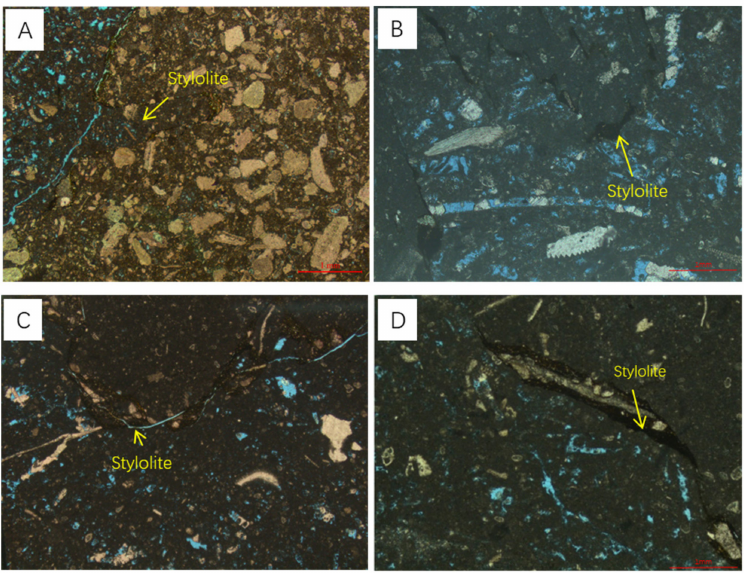
Figure 6. The pressure dissolution features in the thin sections. ( A ) The stylolite developed at the boundary of two lithofacies, type A stylolite; ( B ) the highly serrate stylolite in the green algae packstone, type B stylolite; ( C , D ) the low-amplitude stylolite with thick insoluble residues in the bioclastic wackestone, type C